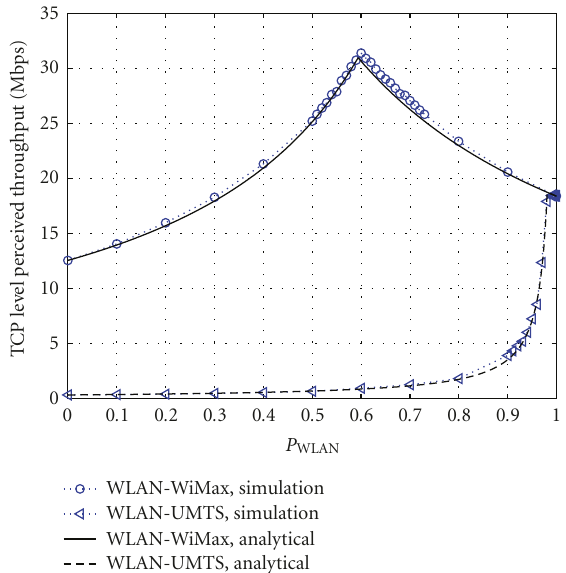
Figure 4: TCP level throughput adopting a WLAN connection and a WiMax or UMTS one, as a function of the probability that the packet is transferred through the